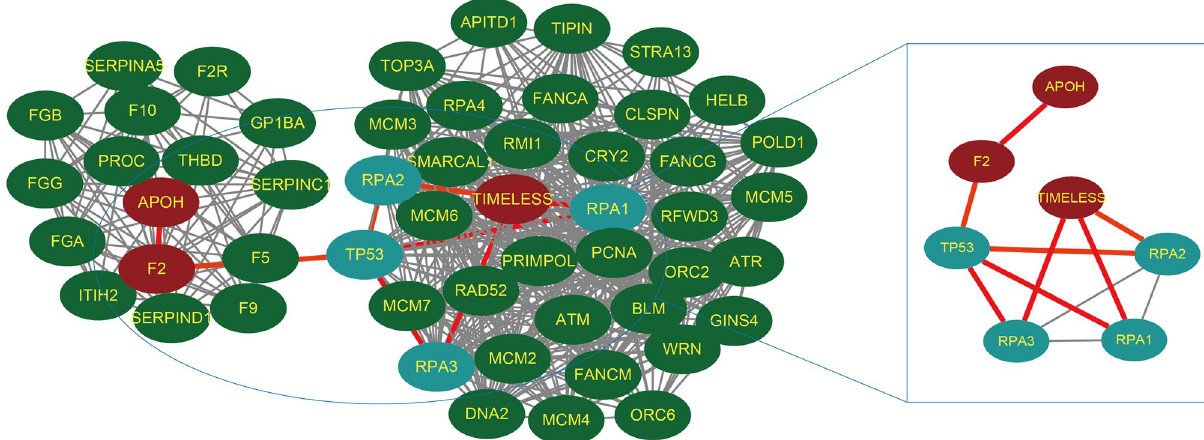
Figure 7. Protein–protein interaction (PPI) networks for aPLs and TIMELESS. Nodes extracted from the PPI networks are the associated nodes interacting with TIMELESS and aPLs. Red colored nodes include the target antigens of antiphospholipid antibodies: APOH (gene of β 2 GPI) and F2 (gene of lupus anticoagulant and